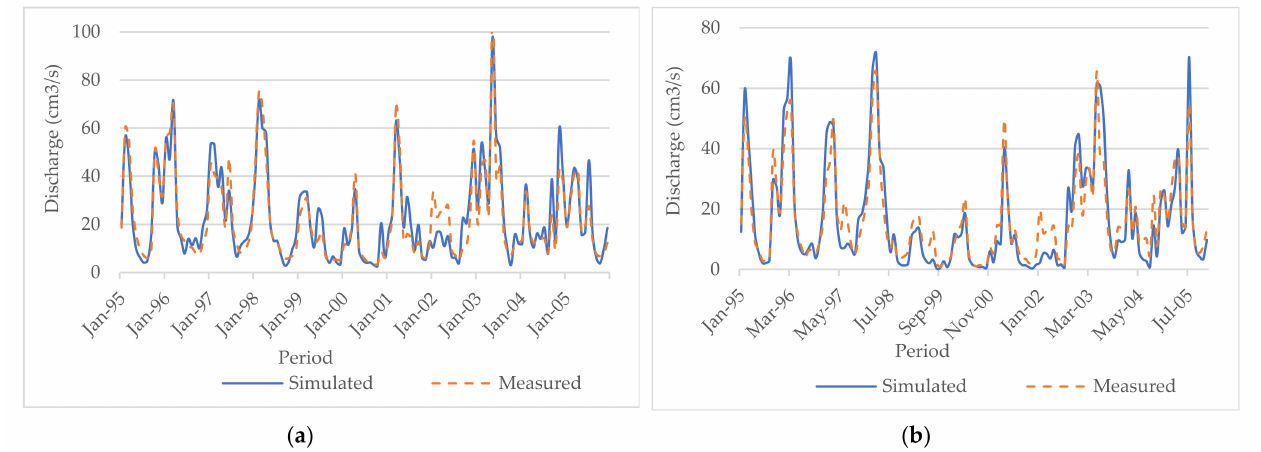
Figure 5. Monthly streamflow hydrographs for ( a ) calibration and ( b ) validation periods at USGS gage 02404400, on the Choccolocco Creek at Jackson Shoal near Lincoln.